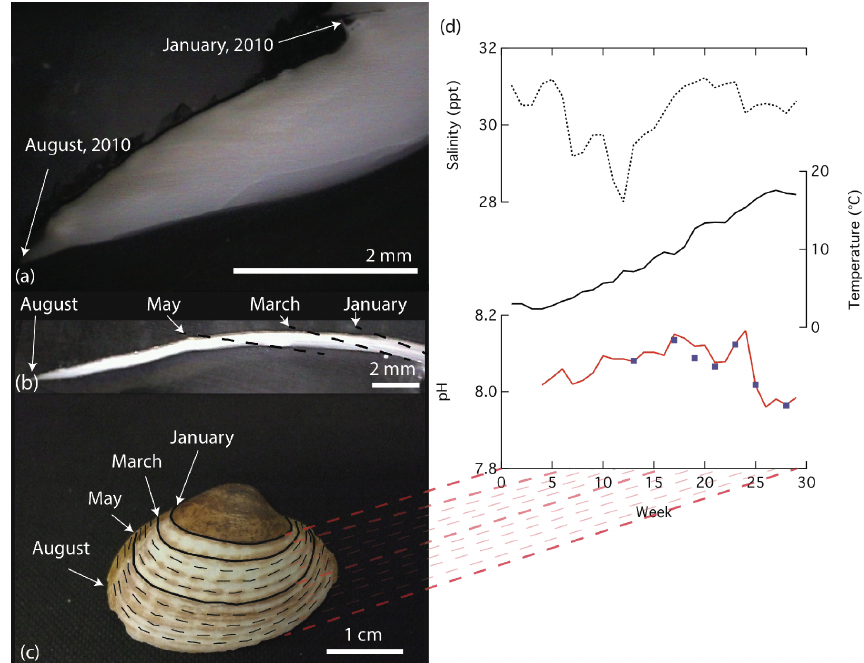
Figure 1. Photos of (a) adult and (b, c) juvenile A. islandica from the culture experiment. External marks on the shell or calcein marks in the cross section were used to constrain shell growth. (d) shows the corresponding in situ measurements of tank water salinity, temperature and pH during the 31-week culture experiment. The juvenile shells were sampled in 10 intervals for this study (c) . Note that because the growth rates differ during the season, each interval represents different time durations (c, d)